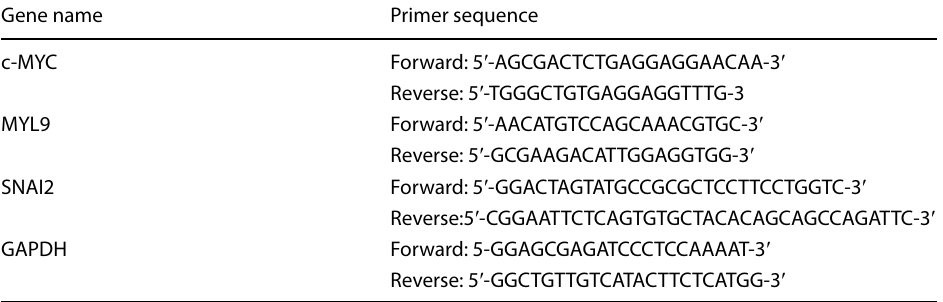
Table 1 Primers used for the